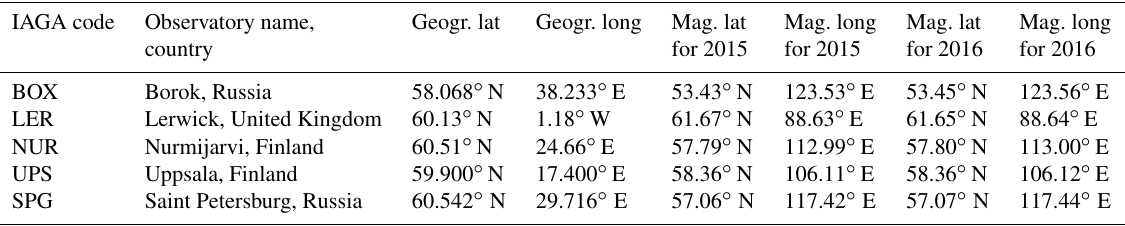
Table 1. Reference information on the observatories whose variation records were chosen to be compared with the Saint Petersburg obser- vatory data.